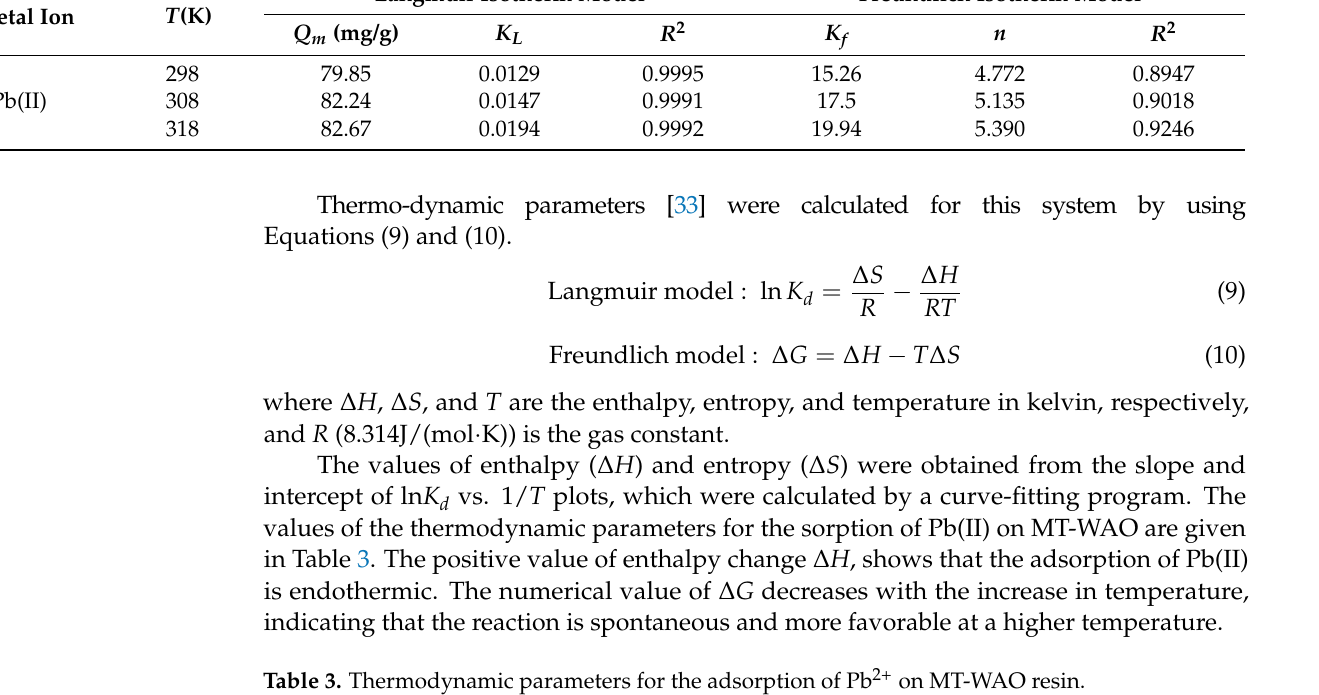
Table 2. The fitting parameters of the adsorption isotherms for the Langmuir and Freundlich models. Langmuir Isotherm Model Freundlich Isotherm Model Metal Ion